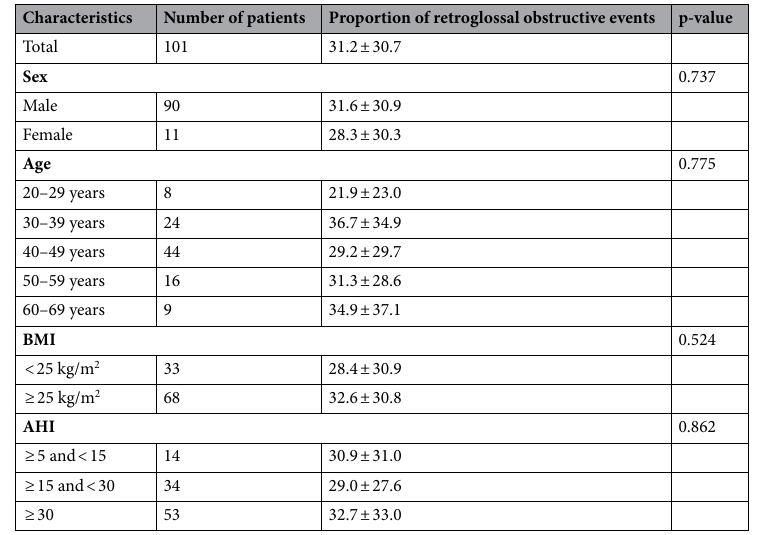
Table 2. Proportion of retroglossal obstructive events with pharyngeal manometry. BMI body mass index, AHI apnea–hypopnea index.